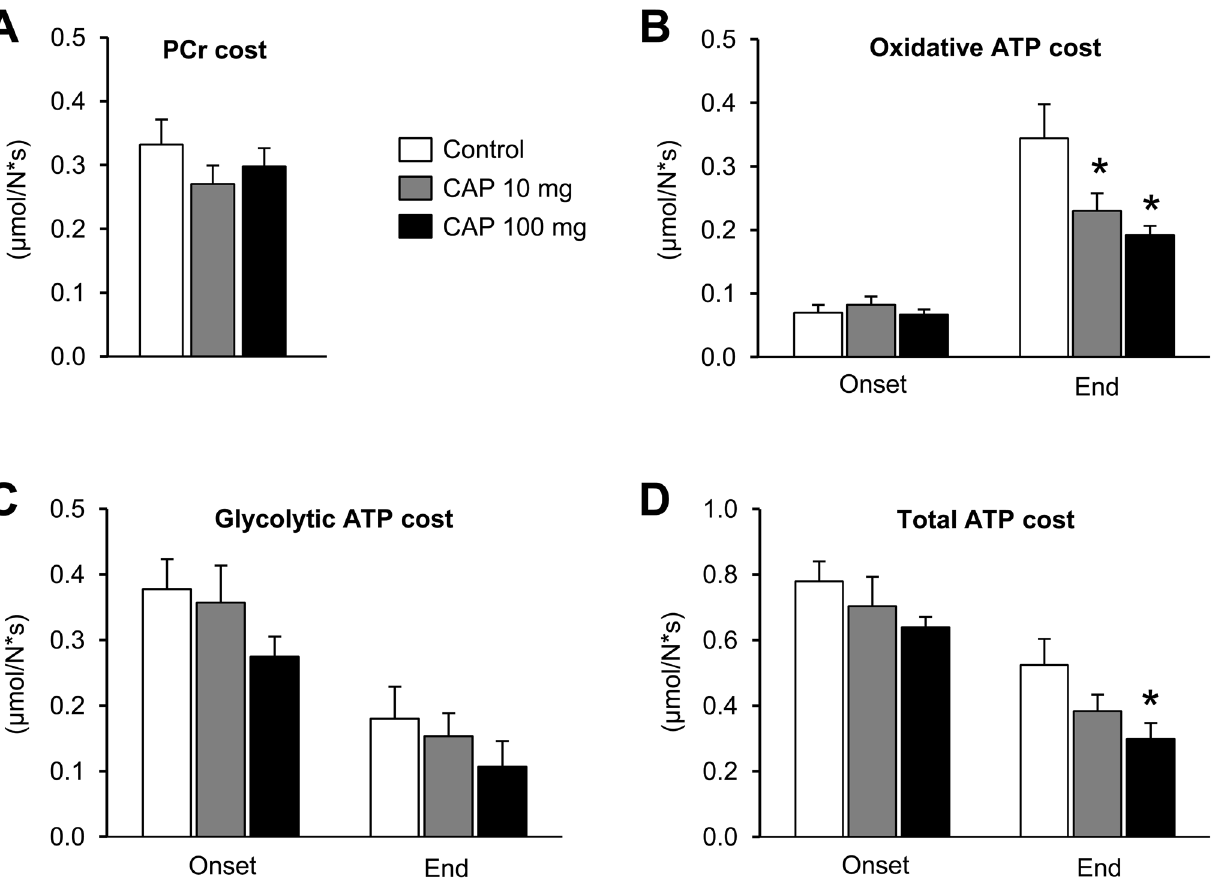
Fig 5. Energy cost of muscle contraction. Effect of 2-week treatment with vehicle (control) or capsiate (CAP) at two different concentrations (10- or 100-mg/kg body weight) on PCr cost (A) and oxidative (B), glycolytic (C) and total (D) ATP cost of contraction at the onset and at the end of the 6-min fatiguing electrostimulation protocol. Data are means ± SEM. * Significantly different from control.